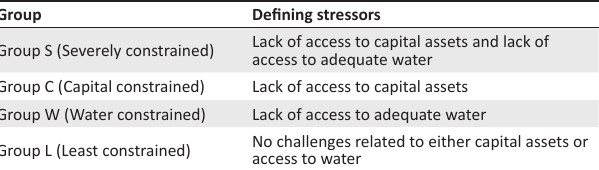
TABLE 1: The four groups in Kasaya, as defined by their respective assemblages of vulnerability. Group Defining stressors Group S (Severely